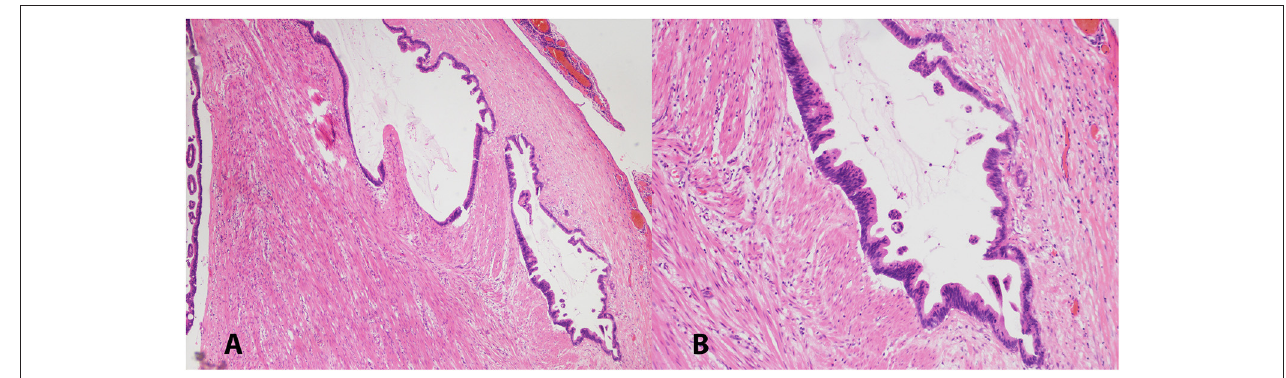
FIGURE 1 | Low ( A , 40X) and high ( B , 100X) magnification pictures of appendiceal mucinous adenocarcinoma. H&E